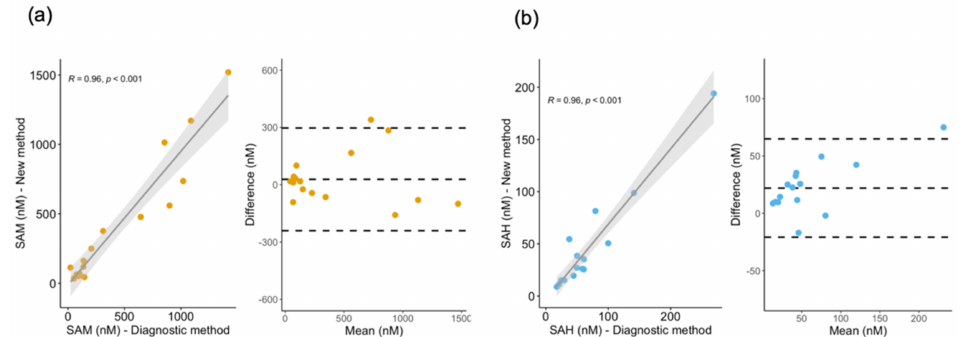
Figure 5. Correlation and Bland–Altman plots of SAM and SAH determinations in plasma by the new method versus an existing diagnostic method. ( a ) Correlation and Bland–Altman plots for the determination of plasma SAM (yellow circles). ( b ) Correlation and Bland–Altman plots for the determination of plasma SAH (blue circles). Grey shadows represent the 95% confidence interval for the linear regression in correlation plots. The middle, dashed line depicts the degree of bias with respect to an ideal 100% accuracy. Differences in concentration values determined by the two methods are predominantly within two standard deviations ( ± 1.96 SD), herein represented by the top and bottom dashed